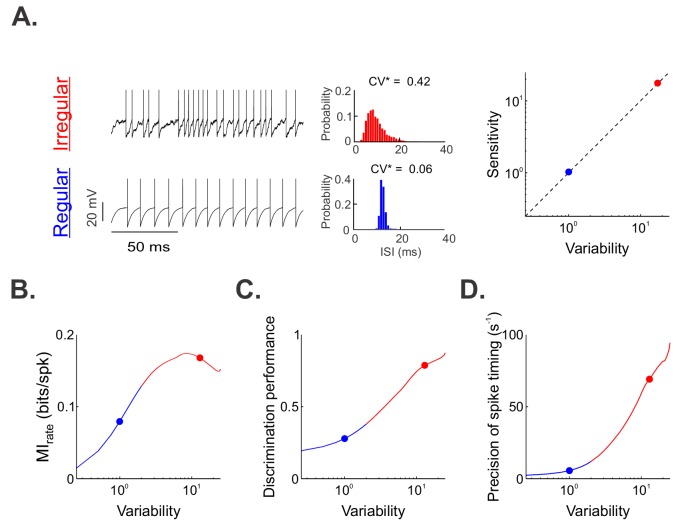
A simple mathematical model based on the leaky integrate-and-fire formalism can reproduce our experimental data by co-varying sensitivity and variability.(A) ( Left) Example resting (i.e., in the absence of stimulation) spiking activity from our model for parameter values that reproduced data from irregular and regular afferents (CV*=0.06). (Middle) Interspike interval histograms from example irregular (top) and regular (bottom) model afferents with CV*=0.42 and 0.06, respectively. (Right) Variability as a function of sensitivity in our model. Both were co-varied such that their ratio remains unity (dashed line). (B, C, D) Mutual information rate (B), performance (C), and precision (D) as a function of variability. The blue and red dots show the values used (A) or obtained (B, C, D) for the regular and irregular afferent models, respectively. Note that because variability and sensitivity were co-varied in our model, the results obtained in (B), (C) and (D) could be similarly plotted as a function of sensitivity instead of variability.